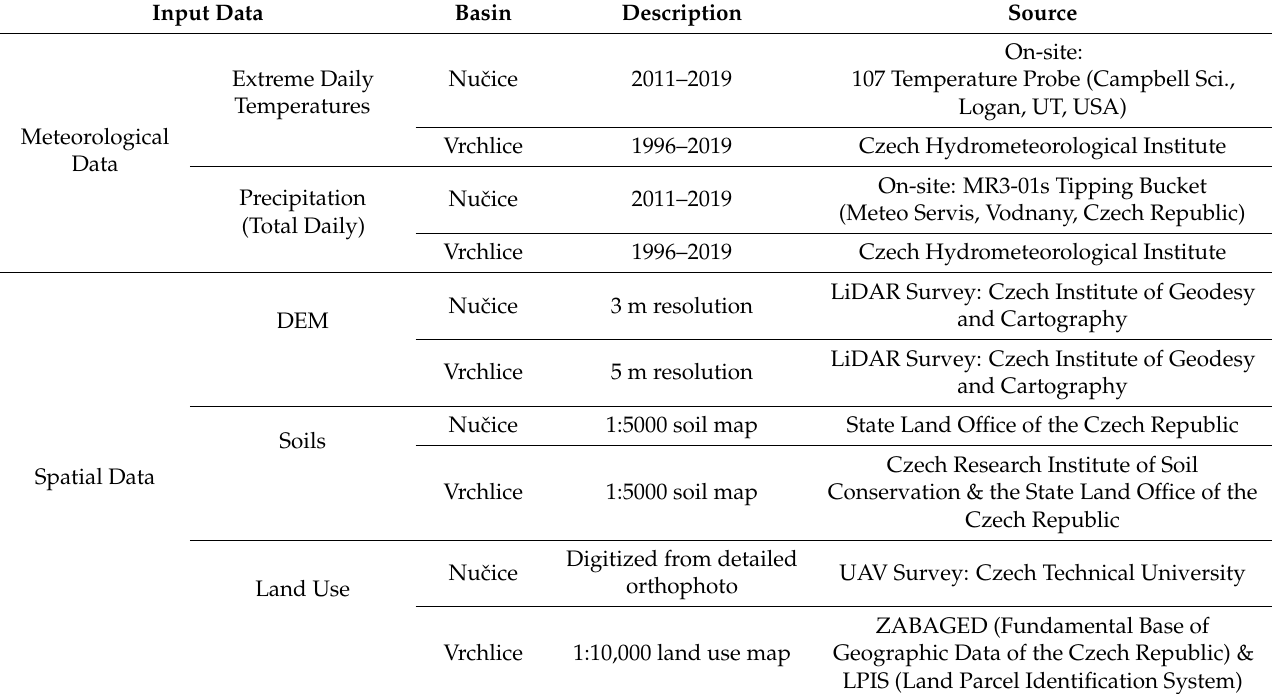
Table 2. Input variables and their sources used for Soil and Water Assessment Tool (SWAT)